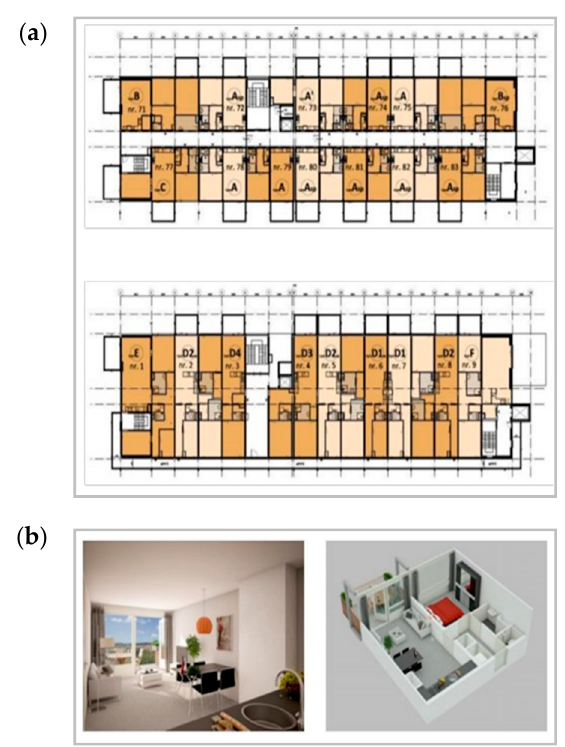
Figure 1. ( a ) Changing from a nursing house ( top ) to student accommodation ( middle ) and ( b ) privately owned apartments ( bottom ) [13].